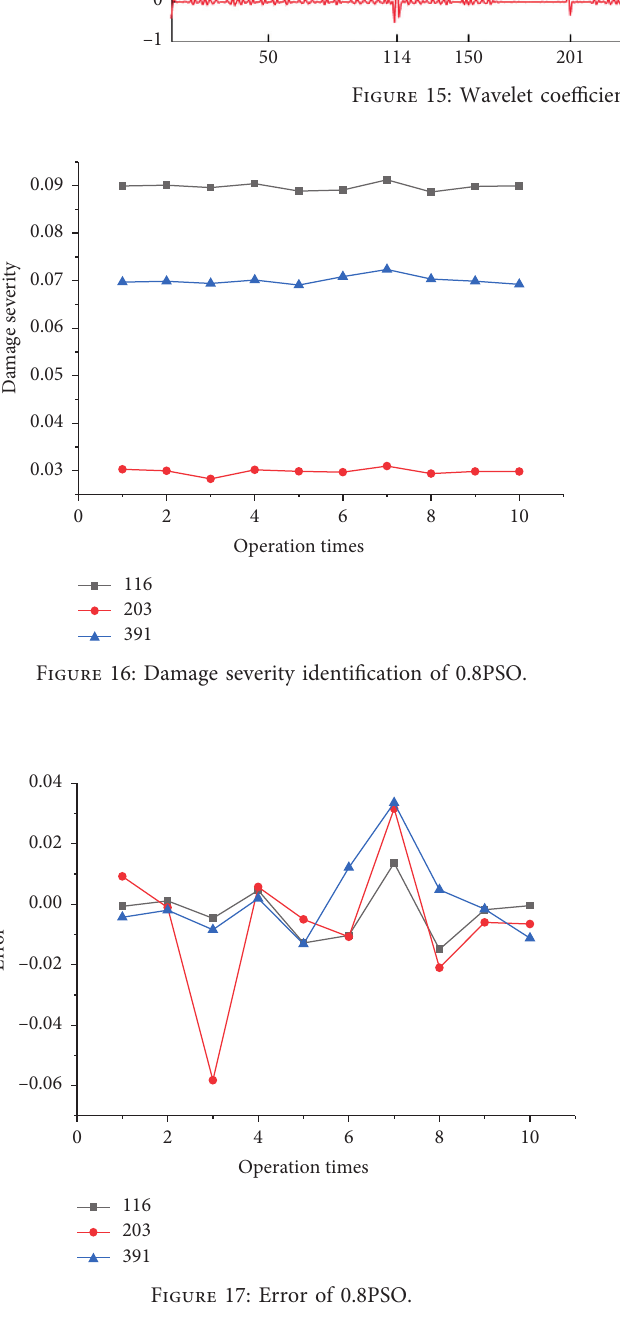
Figure 19: Error of